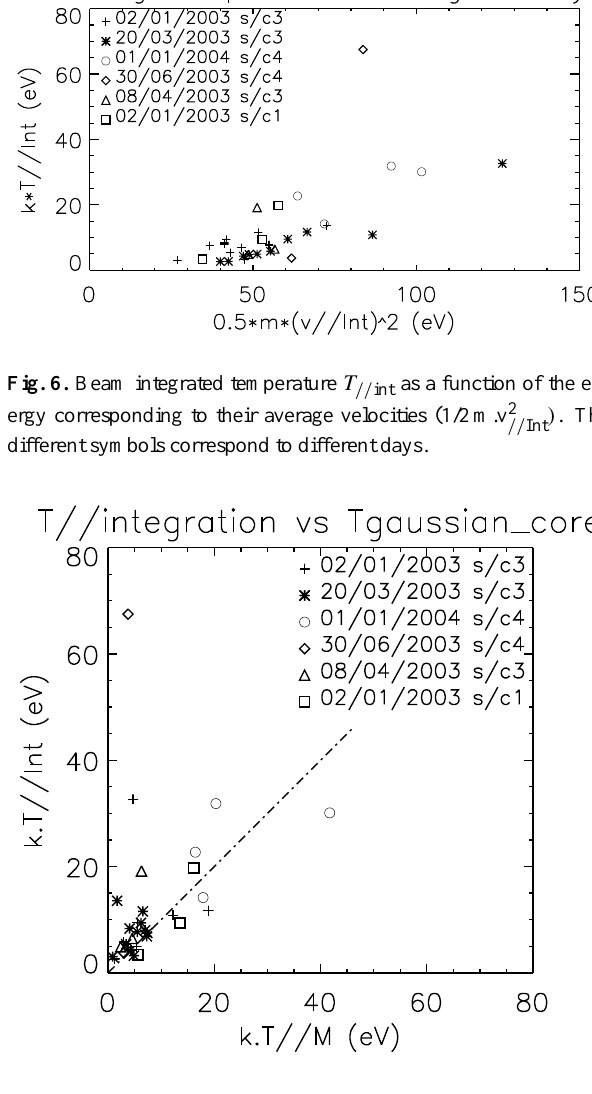
Fig. 7. Beam integrated temperature T // int as a function of the temperature T //M of the best Maxwellian fit. Same symbols as in Fig.